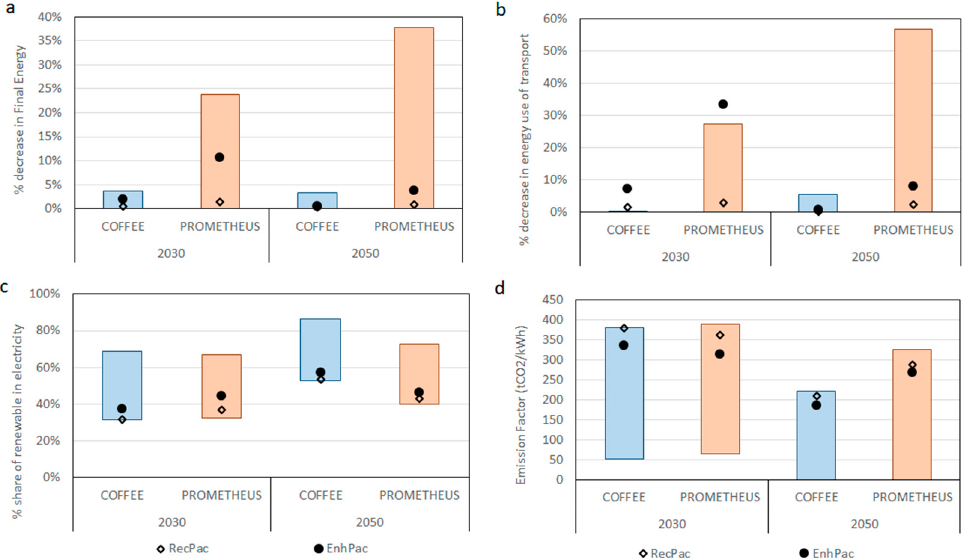
Figure 3. Energy system transformation—decrease in final energy consumption ( a ); decrease in energy use of transport ( b ); share of renewables in electricity generation ( c ); and global emission factor of electricity generation ( d ) in 2030 and 2050.